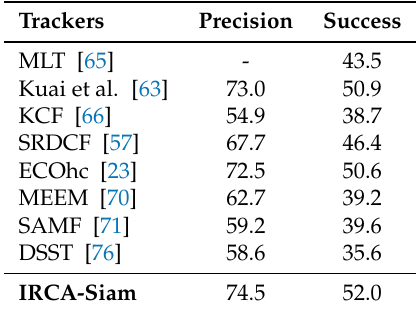
Table 3. Comparison of the proposed method with various state-of-the-art methods over UAV123 using precision and success.